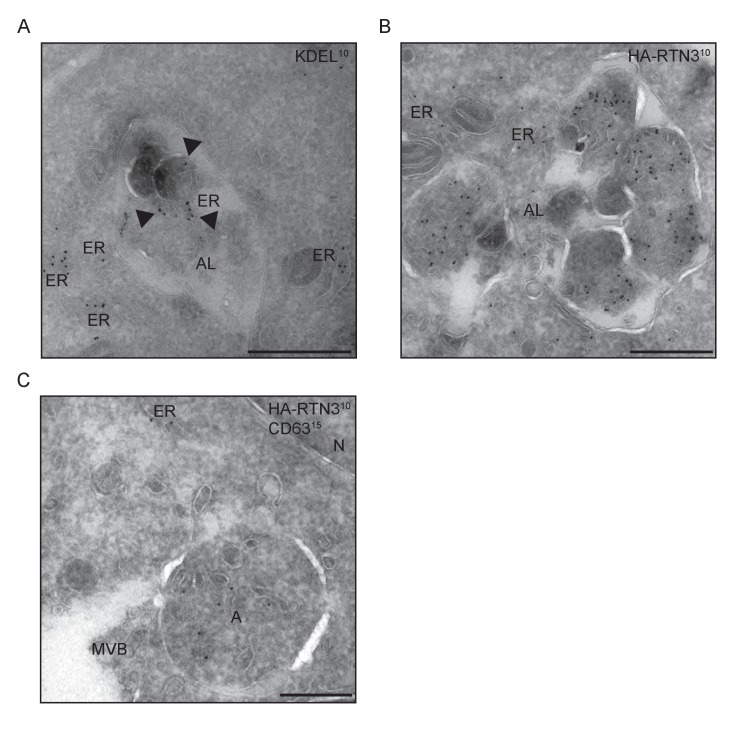
ER membranes and RTN3L are present in autolysosomes.U2OS RTN3L cells were nutrient starved in EBSS for 6 hr in the presence of Bafilomycin A1, 200 ng/ml. (A) Immuno-gold labelling of cryo-sections using antibodies against the KDEL peptide. (B) Immuno-gold labelling for the HA tag peptide. (C) Double immuno-gold labelling against CD63 (large dots, diameter 15 nm) and the HA tag (small dots, diameter 10 nm). AL, autolysosome; N, nucleus; ER, endoplasmic reticulum; MVB, multi-vesicular bodies; A, autophagosome. Scale bar 500 nm.